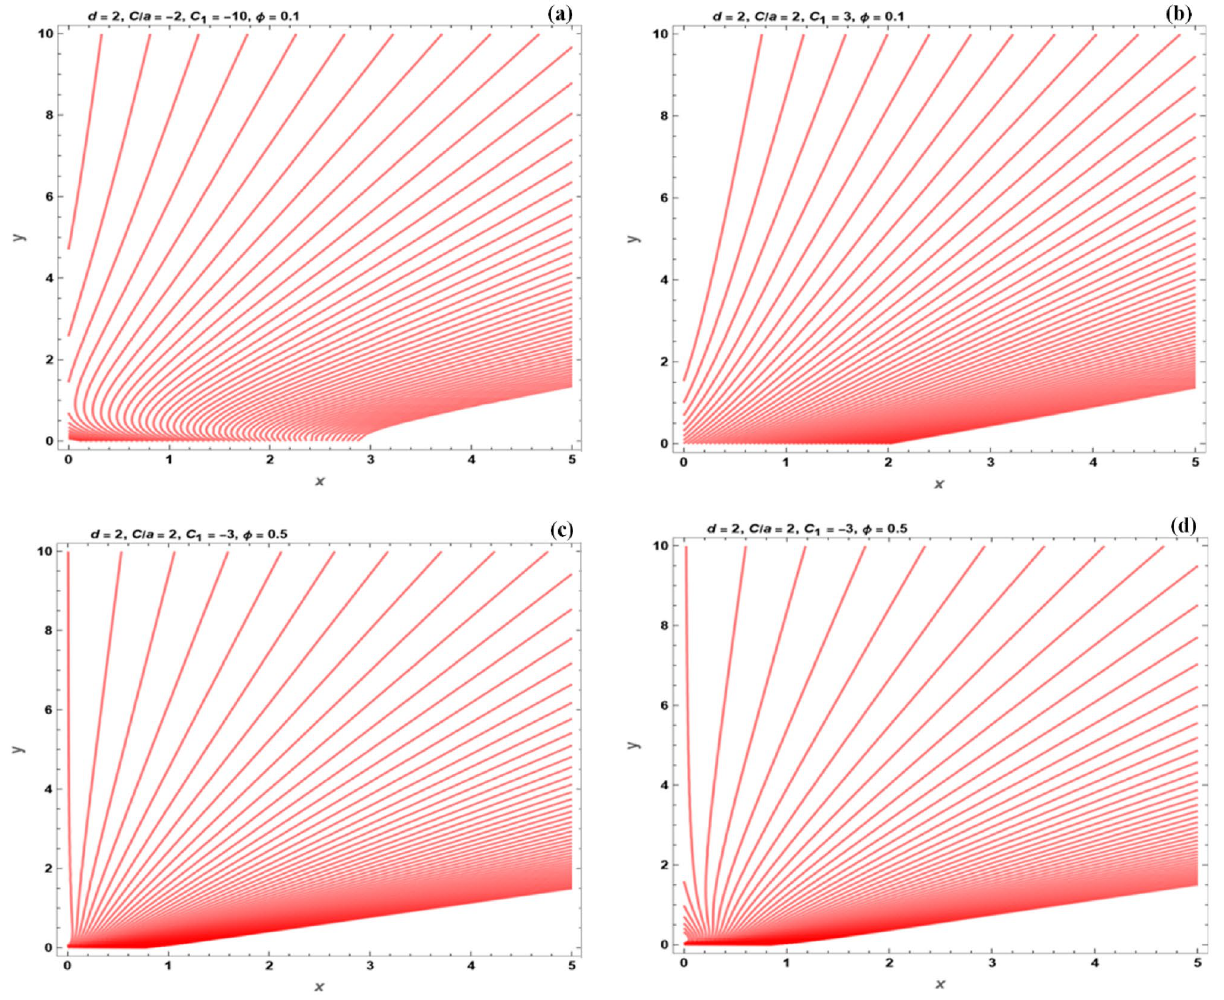
Figure 15. The flow field under the effect of various parameters, for the stretching